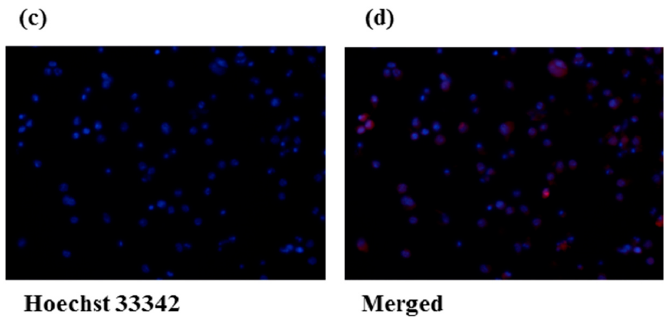
Figure 7. ( a ) Bright field microscopy images of rhodamine B isothiocyanate liposomes treated in RAW 264.7 cells; ( b ) Signal for rhodamine B isothiocyanate channel indicating cytosol staining; ( c ) Signal for Hoechst 33342 channel indicating nuclear staining; ( d ) Merged Rhodamine B isothiocyanate and Hoechst 33342 signals with no co-localization in cells.